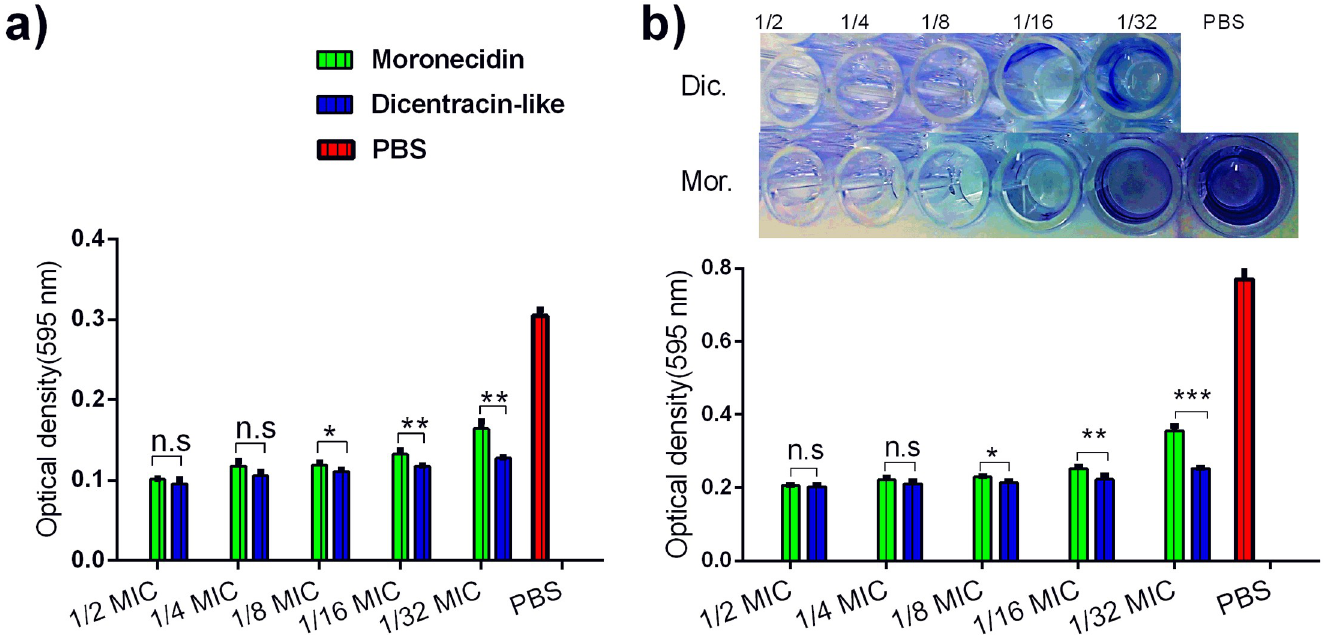
Fig 6. Inhibition of well-surface attachment and biofilm formation of S.aureus by moronecidin and dicentracin-like peptide. Inhibition of surface attachment (a) and biofilm formation was investigated at two-fold serial dilutions of peptides (1/2 to 1/32 MIC). The number of attached cells were measured by ELISA microplate reader and represented as mean ( ± SD) of three independent experiments. PBS represent well without peptide treatment (negative control) � , p - value � 0.05; �� p - value � 0.01; ��� p - value � 0.000.1; n.s, no significant; p - value � 0 . 05 was considered as no significant difference.